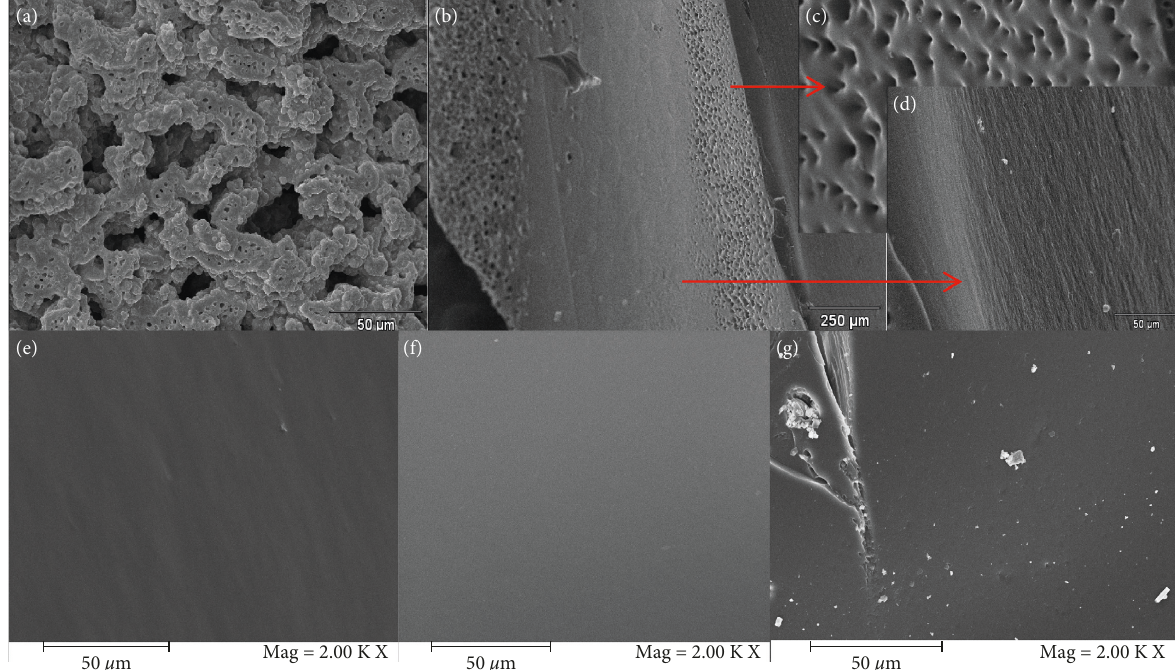
Figure 2: SEM images of hydrogels cross section: (a) sample A at 50 µ m: general morphology; (b) sample B at 250 µ m; (c) porous region magnification of sample B at 50 µ m; (d) dense region magnification of sample B at 50 µ m; (e) sample C at 50 µ m; (f) sample D at 50 µ m; (g) sample E at 50 µ m.